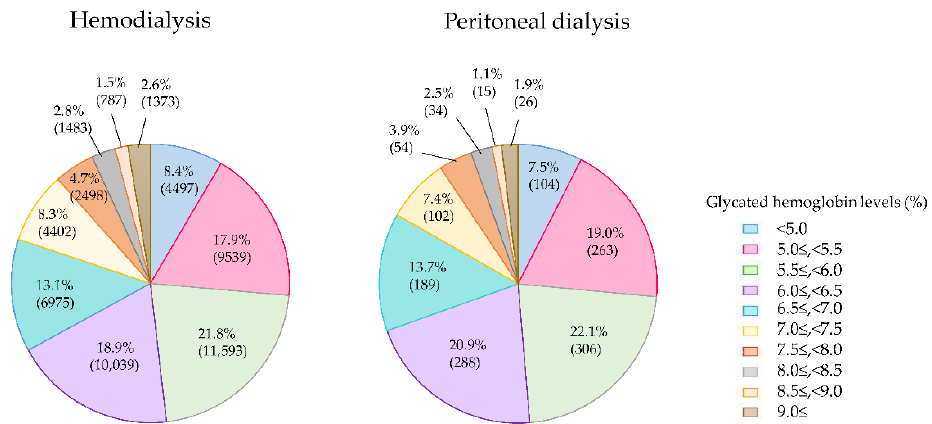
Figure 4. Glycated hemoglobin (HbA1c) levels of diabetes patients on hemodialysis and peritoneal dialysis in 2018.